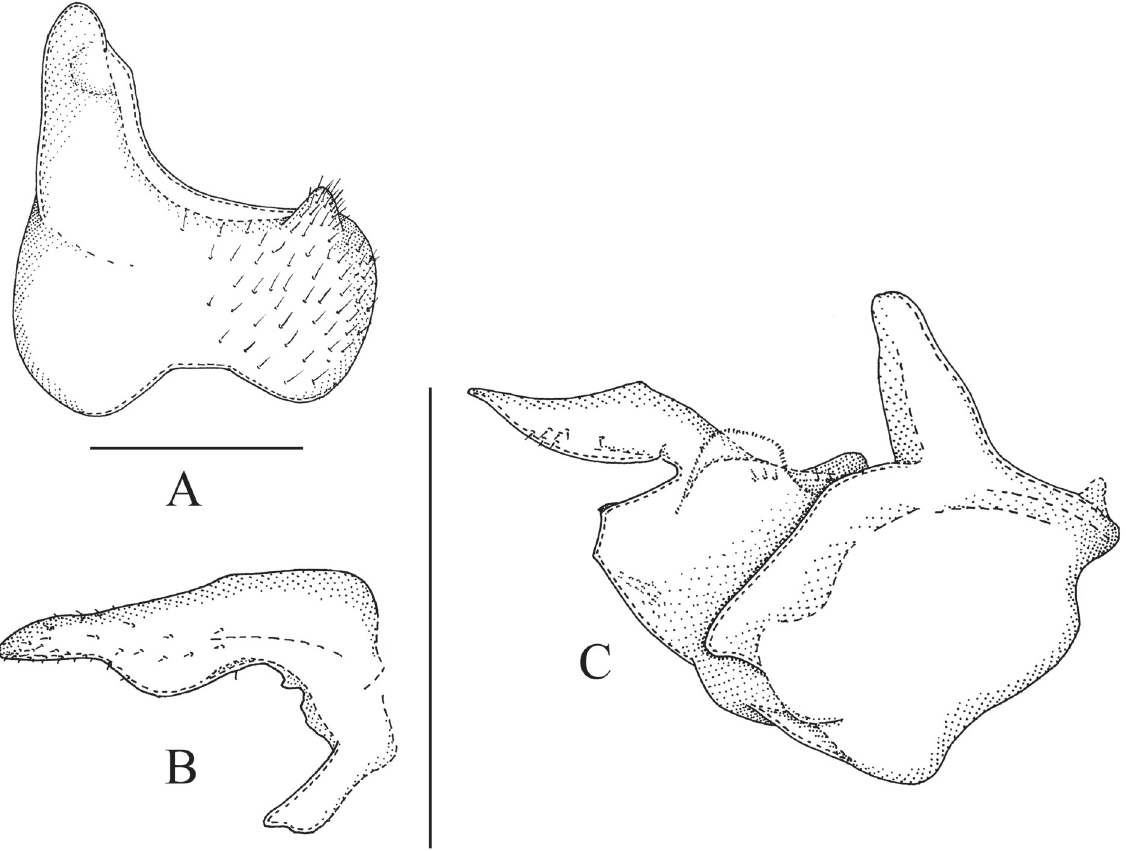
Fig. 29. Sphegina (Asiosphegina) exilipes sp. nov., holotype, ♂ . A . Sternum IV, ventral view. B . Ri ght surstylus, lateral view. C . Right sternum IX and superior lobe, lateral view. Scale bars = 0.5